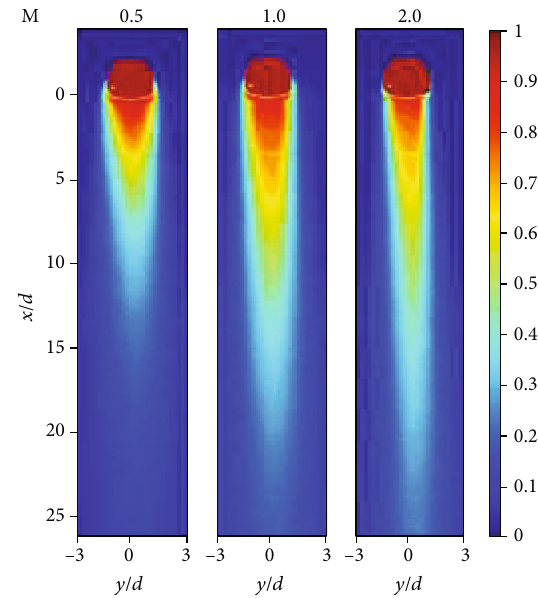
Figure 10: Experimental contours of θ = 14 ° .